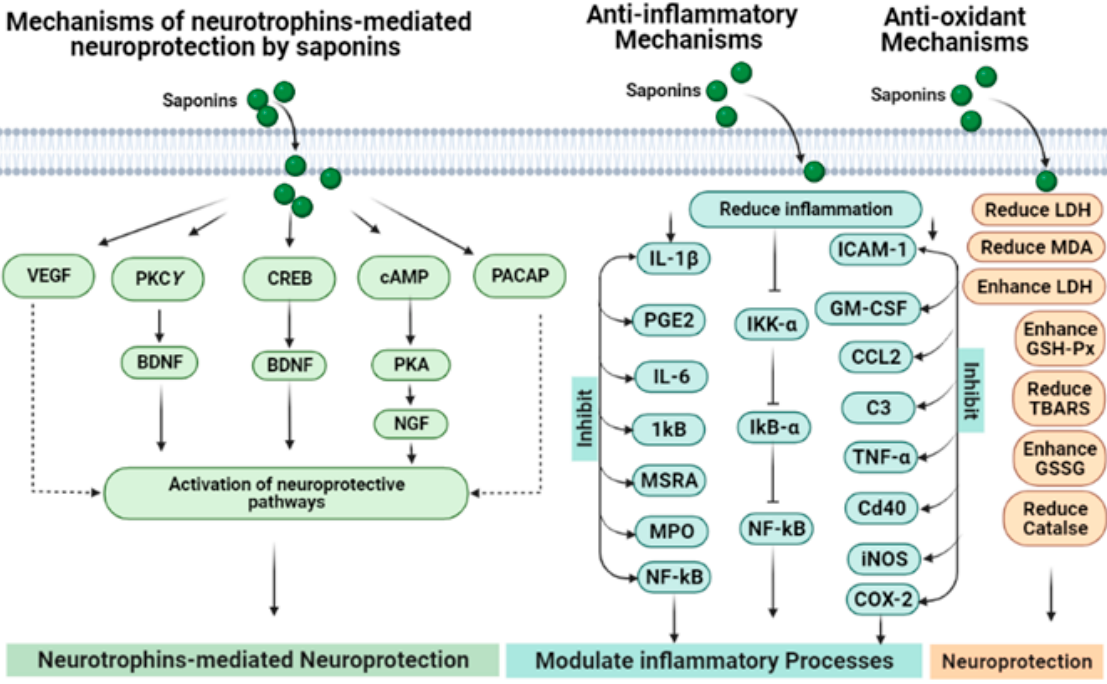
Figure 7. Involvement of neurotrophic modulation, anti-inflammation and anti-oxidant mechanisms in the neuroprotective potentials of saponins. in the neuroprotective potentials of